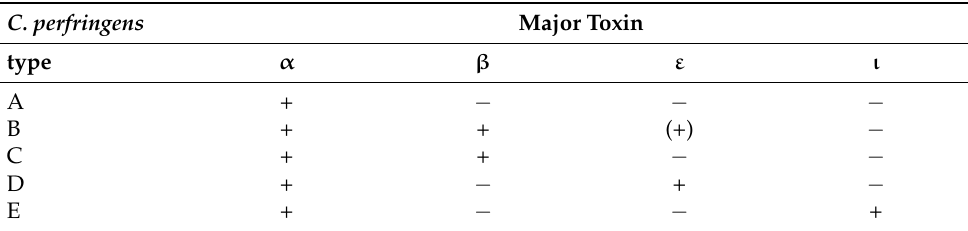
Table 1. Classification of C. perfringens into five toxin types and the associated major toxins; + = major toxin present; − = major toxin not present, as described by Markey et al.